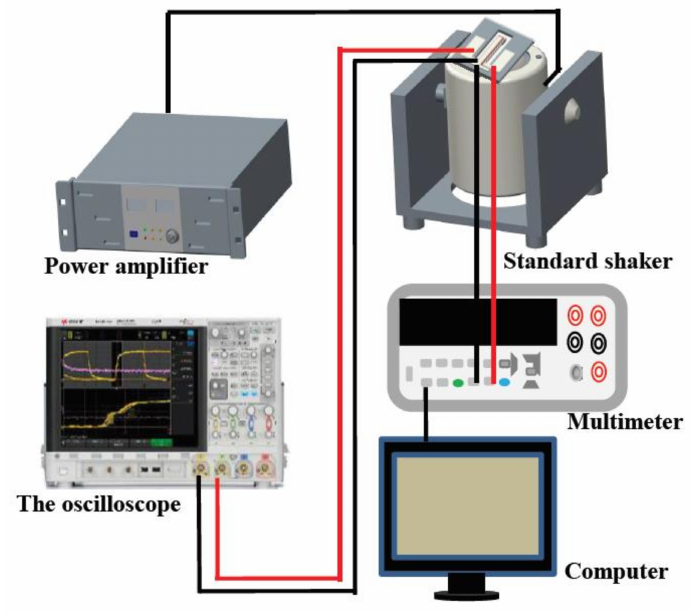
Figure 9. The testing system of the acceleration sensor.